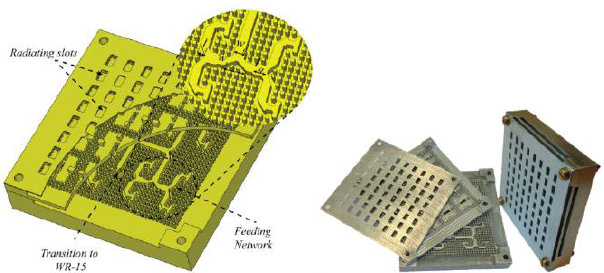
Figure 3: Corporate-fed planar slot antenna array for 60 GHz